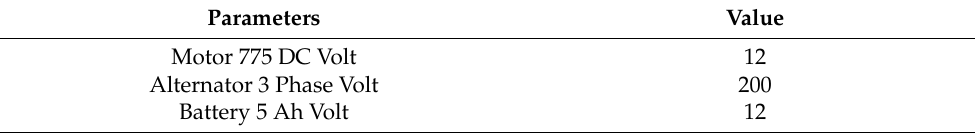
Figure 1. Continuously circulating electrical power diagram design in a motor-driven system. Table 1. Core technology for continuous cyclic power generation in motor-driven systems.